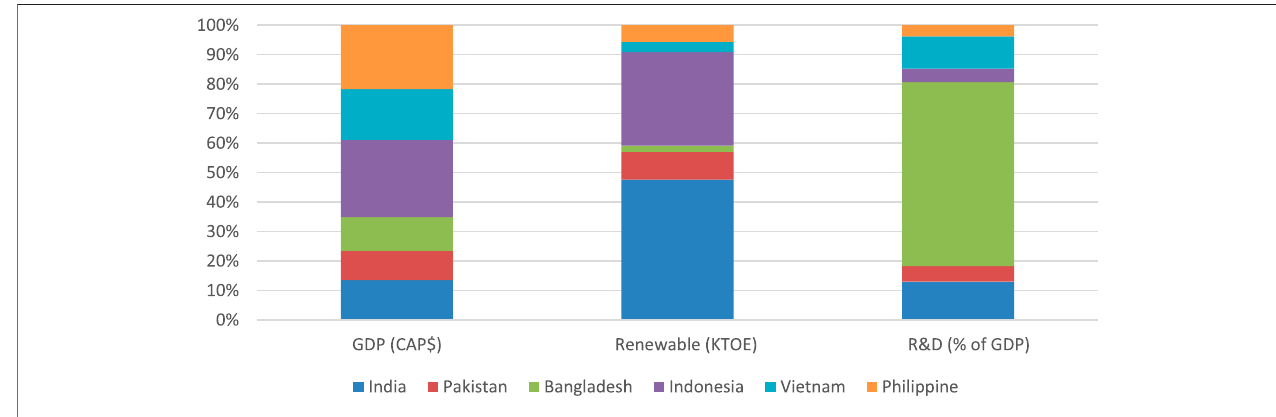
FIGURE 1 | Performance of selected South-East developing economies.